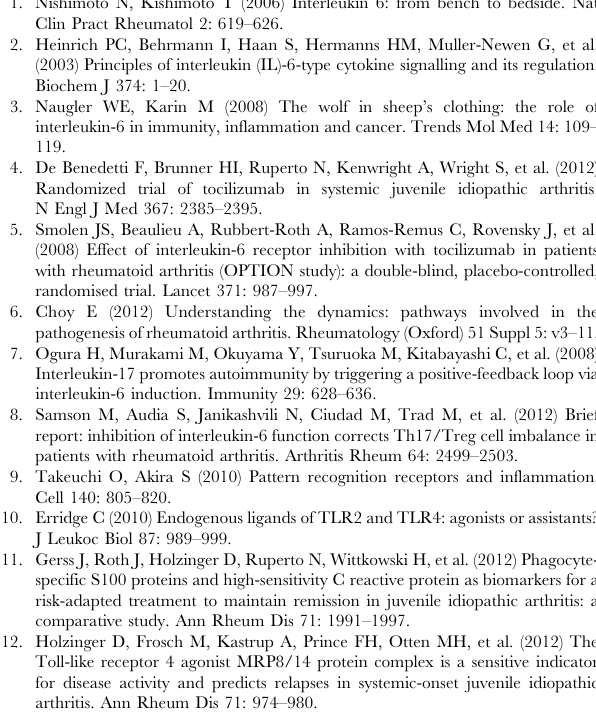
Figure S3 Effects of exposure to IL-6 on the production of TNF- a in human PBMCs in response to TLR ligands. Human PBMCs were pre-exposed to IL-6/sIL-6R for 1 hour. Cells were then stimulated with CpG (5 m g/ml), PAM (200 ng/ ml), poly(I-C) (20 m g/ml), MDP (10 m g/ml), LPS (10 ng/ml) for 18 hours. TNF- a levels were measured by ELISA. *p , 0.05 for values from IL-6/sIL-6R-stimulated compared with NT cells. (TIF) Figure S4 Effects of exposure to IL-6 on the production of TNF- a in human PBMCs in response to IL-1 b . Human PBMCs were pre-exposed to IL-6/sIL-6R for 1 hour. Cells were then stimulated with IL-1 b (1 ng/ml) for 18 hours. CXCL8. TNF- a levels were measured by ELISA. Figure S5 Effects of exposure to IL-6 on the expression of TLR4 in human PBMCs in response to LPS. Human PBMCs were pre-exposed to IL-6/sIL-6R for 1 hour. Cells were then stimulated with LPS (10 ng/ml) for 6 hours. Quantitative reverse transcription–polymerase chain reaction was performed on total RNA, with TLR4 mRNA normalized to GAPDH mRNA